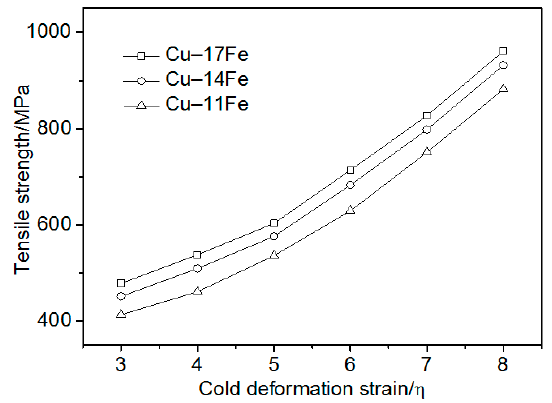
Figure 2. Cu–Fe strength vs. the cold deformation strain.